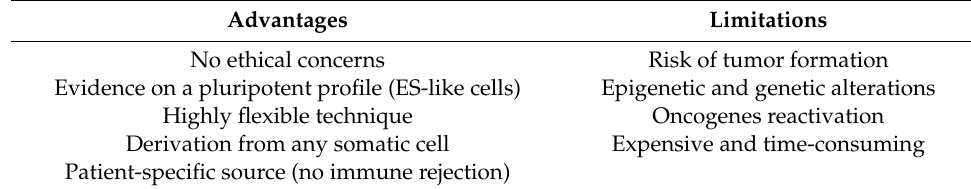
Table 1. Overview of the advantages and limitations of induced pluripotent stem cells generation and establishment from somatic cells.